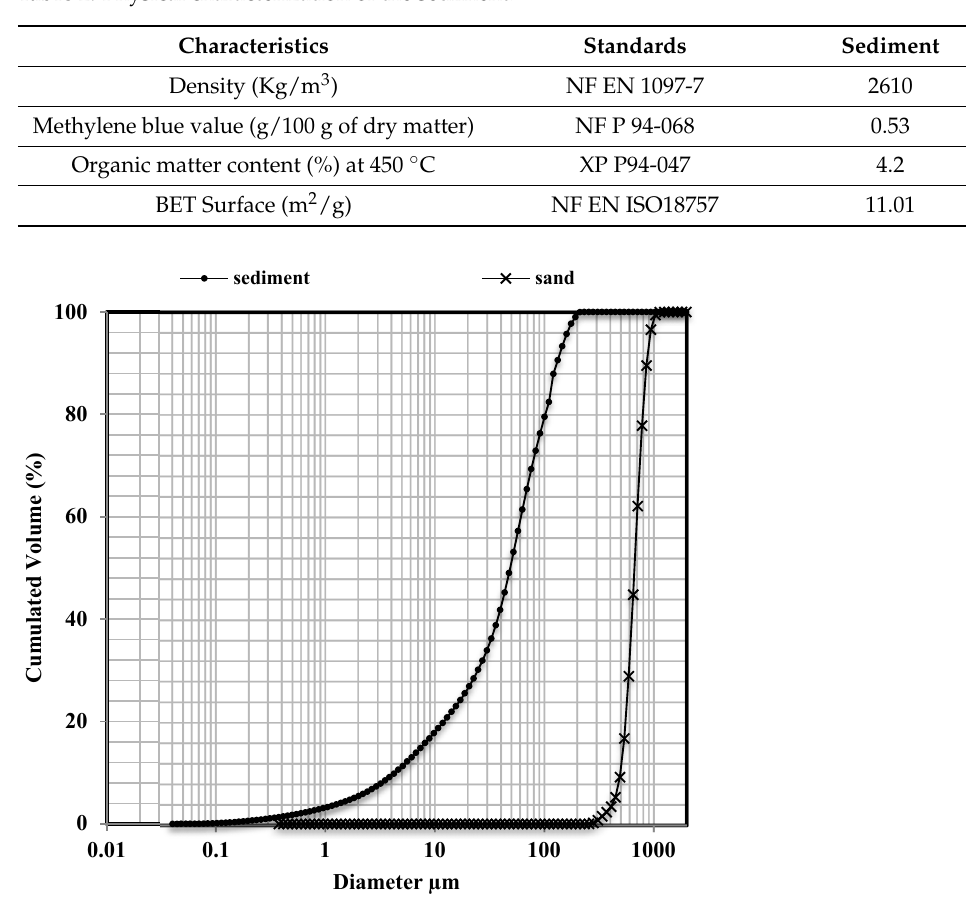
Figure 1. Comparison of particle size distribution in the sediment sample and the normalized sand used in the polymer mortar mixtures. Table 3. Chemical composition of raw sediment according to X-ray fluorescence analysis .